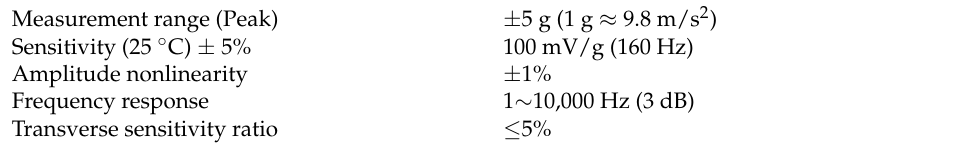
Table 1. Dynamic performance of YXS-8908 vibration acceleration